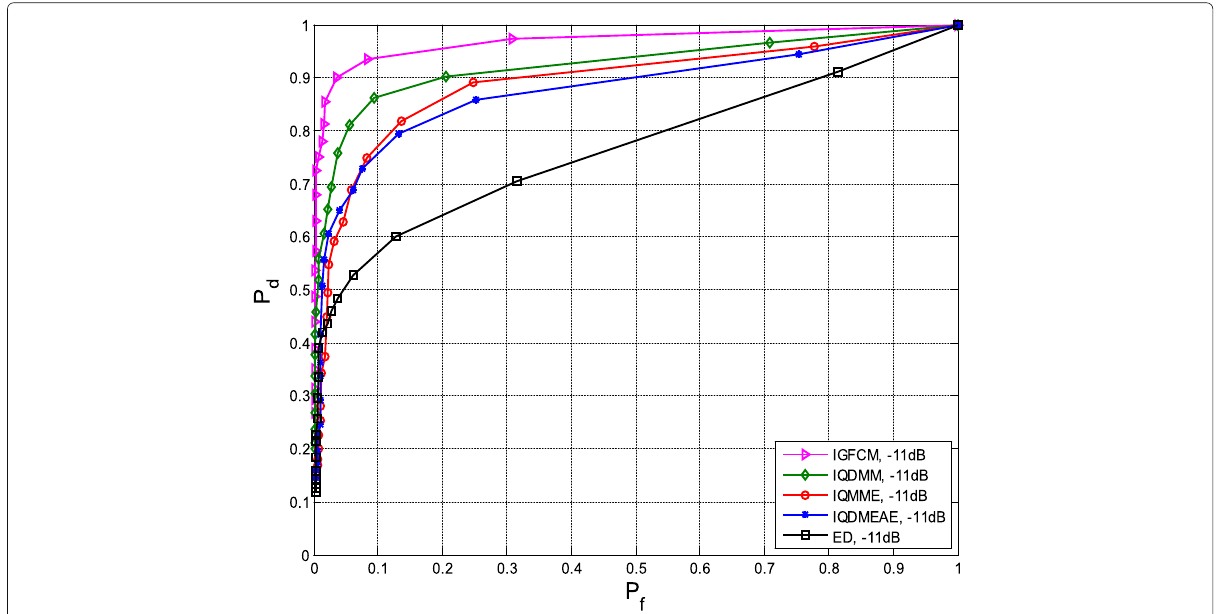
Fig. 7 ROC curves for different algorithms at SNR = − 11 dB and M =